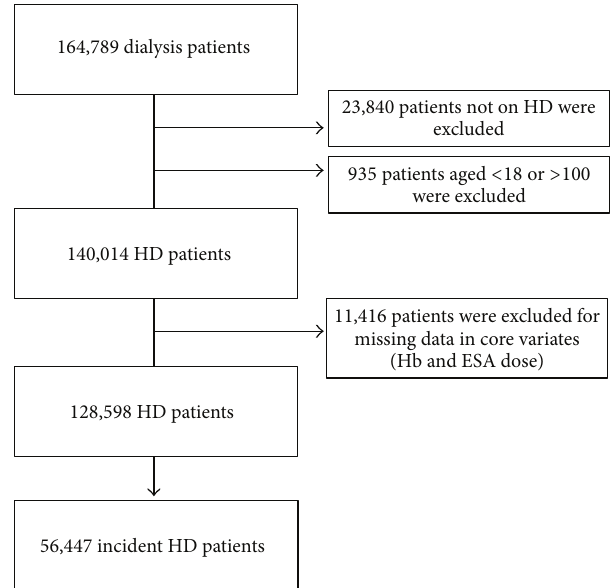
Figure 1: Flowchart of patient